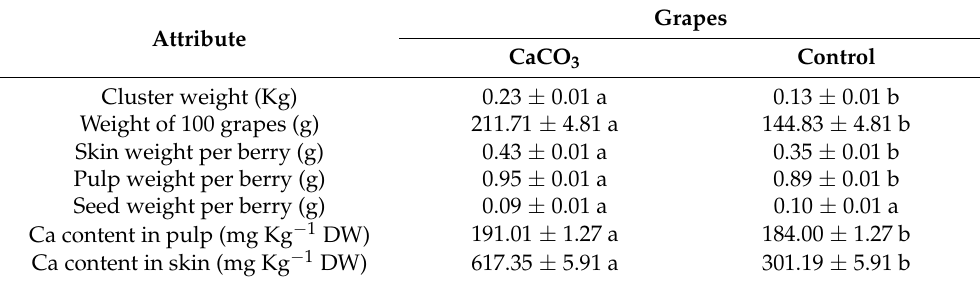
Table 2. Effect of the foliar application of CaCO 3 residues on fruit yield, proportions of anatomical parts of grapes, and Ca content in fruit skin and pulp of ‘Shiraz’ grapes.